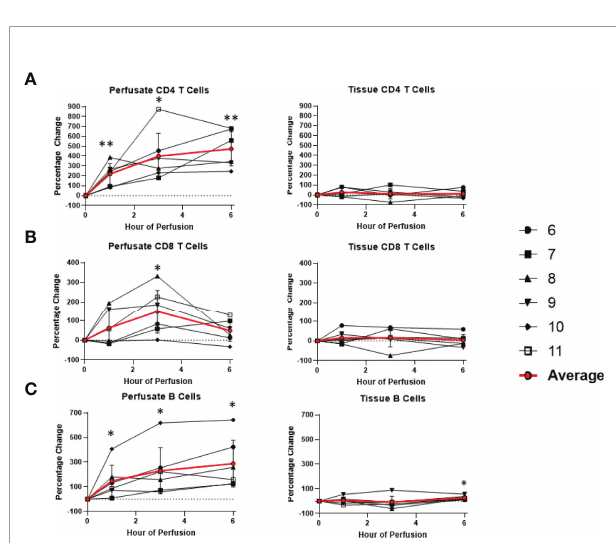
FIGURE 7 | Percentage change of frequency of cells from lymphocyte lineage during perfusion. A percentage change of 0% suggests there is no change in the innate immune cell frequency from time point 0 th hour. Average values of percentage changes (red line) as well as standard deviations were calculated (vertical bar). A two-sided, paired t-test was performed to compare percentages of each time point to those at time 0H. (* P<0.05; ** P<0.01). (A) Perfusate CD4 T cell frequency increased at the 1 st hour of perfusion (+218.9 ± 104.6%) and continued to increase at the 6 th hour (+472.6 ± 172.5%) without changes to tissue CD4 T cell frequency. (B) Perfusate CD8 T cell frequency increased at the 3 rd hour of NMP (+147.4 ± 111.3%) and returned to baseline at the 6 th hour without changes to tissue CD8 T cell frequency. (C) Perfusate B cell frequency increased at the 1 st hour of perfusion (+147.4 ± 127.5%) and continued to increase at the 6 th hour of perfusion (+288.5 ± 189.2%), while tissue B cell frequency increased at 6 th hour of perfusion (+26.3 ± 16.0%).